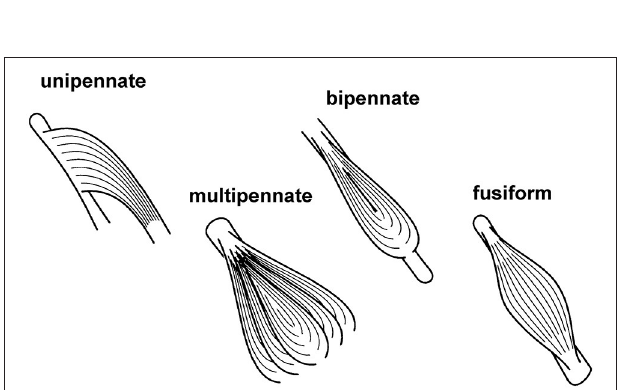
FIGURE 8 | Schematic structural hierarchy of a skeletal muscle. The entire muscle is made up of fascicles, fascicles are made up of fibers (cells), and fibers are comprised of myofibrils. Each structural entity of the muscle is surrounded by connective tissues that connect the various structural levels with each other and connect the entire muscle to other muscles, bones, and fascia. The connective tissue layers are referred to as the epimysium, perimysium, and endomysium, as indicated in the figure.